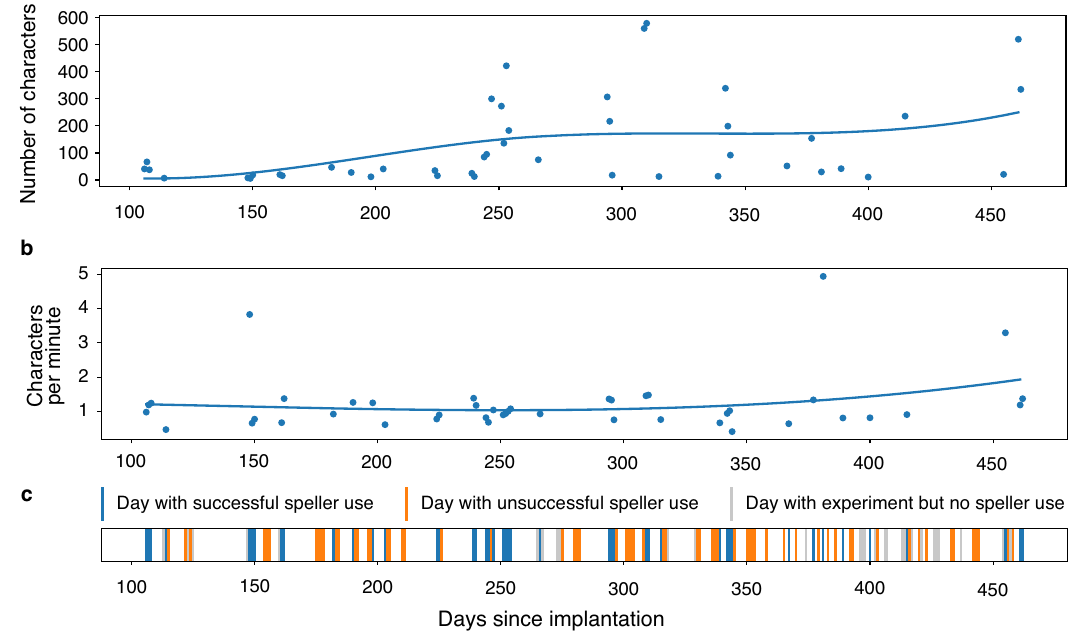
Fig. 4 Overview of BCI use. a Number of characters spelled by the patient during speller sessions whose output was rated ‘ intelligible ’ (rating described in text), aggregated by day. b Characters selected per minute in ‘ intelligible ’ speller sessions, aggregated by day. c Speller use during the period presented. Sessions span 135 days. Green bars represent days on which speller was used and yielded intelligible output (44 days). Yellow bars represent days on which speller use was attempted, but no intelligible output was produced (63 days). On 28 days, speller use was not attempted (red). Source data are provided as a Source Data fi works so effortlessly ’ . The patient expressed his desire to have Day 253, ‘ tell alessandro i need to save edit and delete whole different kind of food in his tube as, ‘ mixer fuer suppen mit fl eisch ’ – ‘ instructed his wife to buy a mixer for soup with meat ’ phrases and all of that into the list where (patient ’ s son name) on day 295, ‘ why cant you leave the system on. i fi nd that good ’ on on day 247 ’ ; ‘ gulaschsuppe und dann erbsensuppe ’ – ‘ Gulash soup day 461, in English as the patient knew that the experimenter UC and sweet pea soup ’ on day 253; ‘ wegen essen da wird ich erst mal and AT are not native German speakers and mostly spoke in des curry mit kartoffeln haben und dann bologna und dann English with the patient. On day 247 he gave his feedback on gefuellte und dann kartoffeln suppe ’ – ‘ for food I want to have speller as, ‘ jungs es funktioniert gerade so muehelos ’ , - ‘ boys, it curry with potato then Bolognese and potato soup on day 462. He